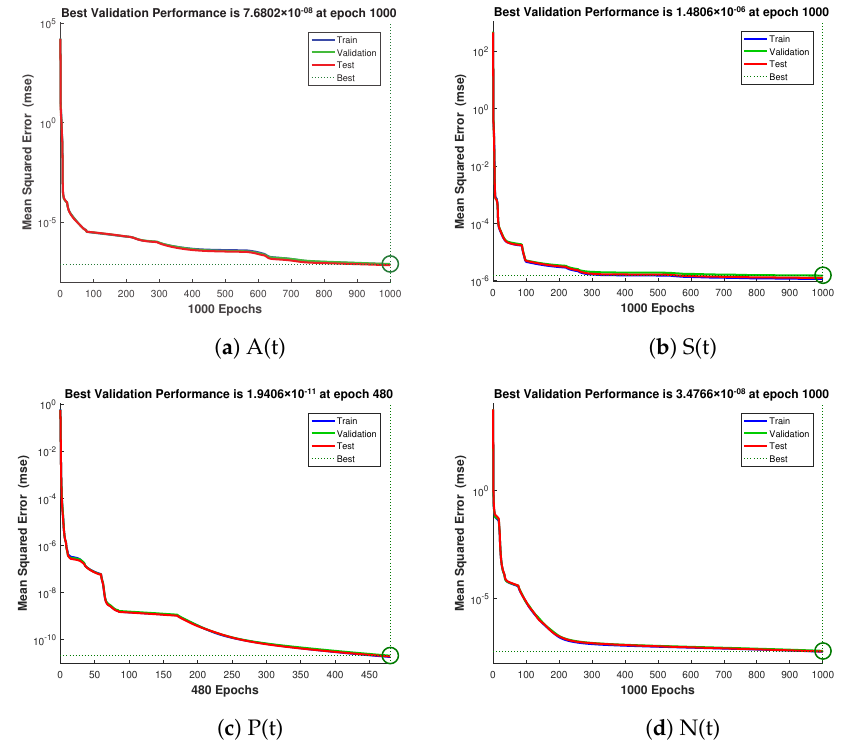
Figure 4. Mean square error of NNs-LMT for crop production, insects density, insecticides concentra- tion, and external effort of case